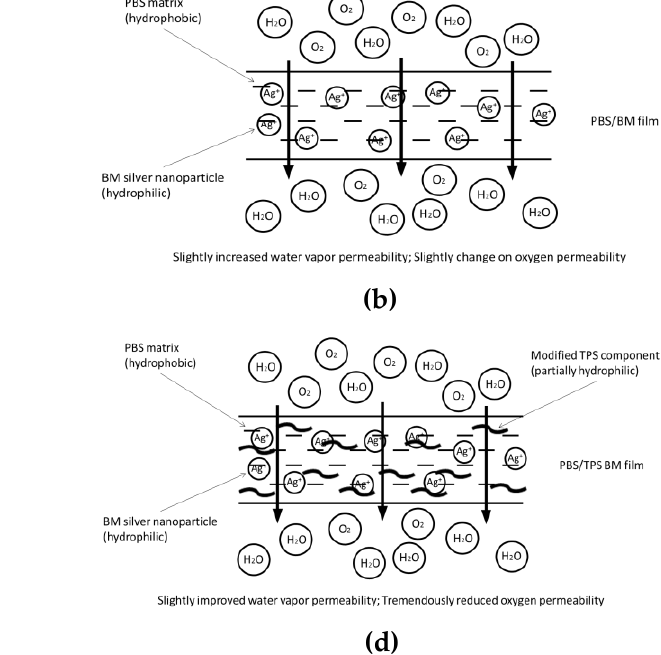
Figure 6. Schematic diagrams of ( a ) PBS, ( b ) PBS/BM, ( c ) PBS/TPS, and ( d ) PBS/TPS BM films in response to the penetration of oxygen and water.